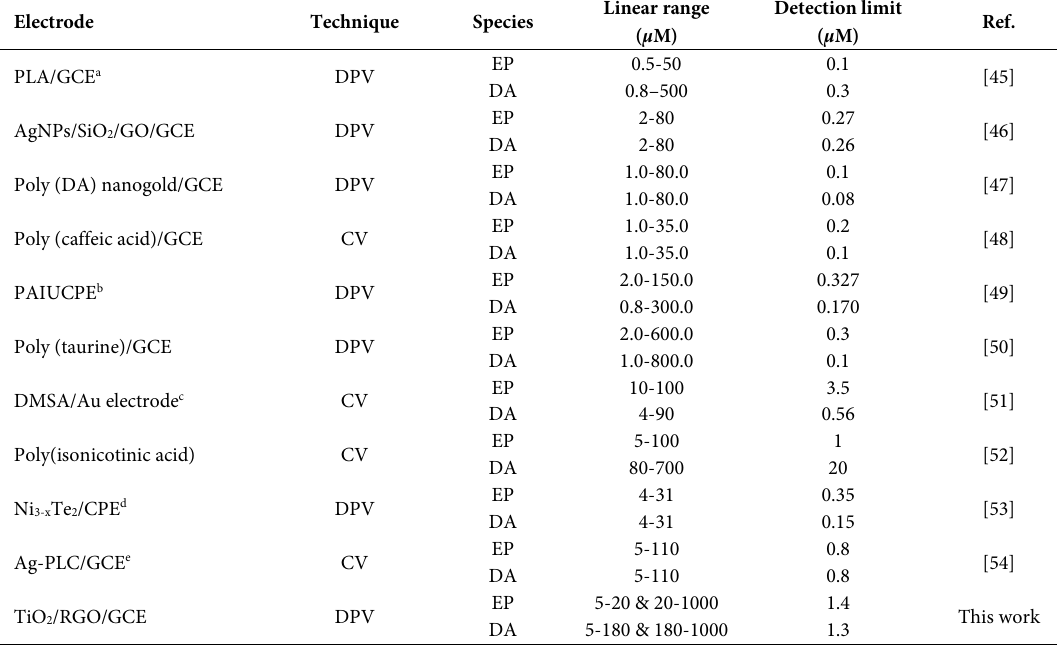
Table 1 Comparison for simultaneous determinations of DA and EP at the different modified electrodes. Table 1. Comparison for simultaneous determinations of DA and EP at different modified